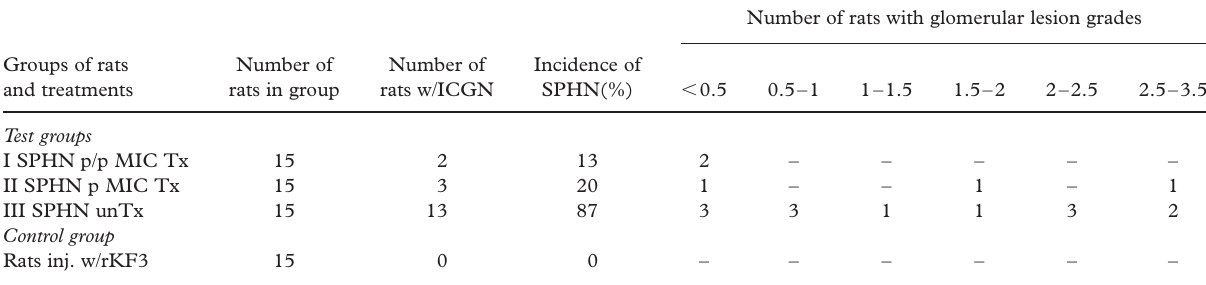
Number of rats with glomerular lesion grades